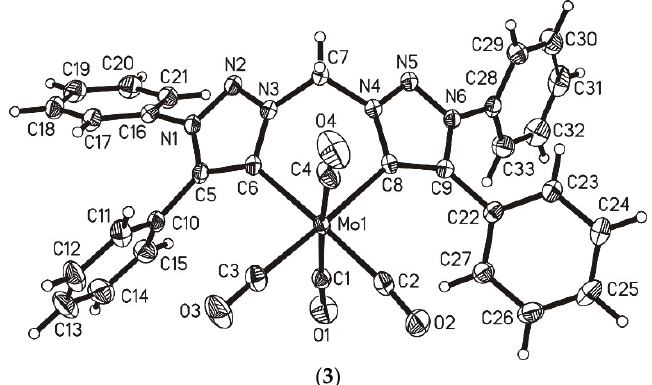
Figure 2. Molecular structure of 1,5-diphenyl-1H-1,2,3-triazole (( 1 ); R = 2.93%, R int = 3.79%), 3,3 ′ -methylenebis(1,5-diphenyl-1H-1,2,3-triazol-3-ium) triflate (( 2 ); R = 4.24%, R int = 8.66%), and [Mo(CO) 4 (bta)] ( 3 ); R = 3.05%, R int = 5.23%). In case of ( 2 ), the two triflate counter ions and in case of ( 3 ), a co-crystallized CH 2 Cl 2 are omitted for clarity reasons. Ellipsoids are shown at the 50% probability level. Table 1. Selected bond lengths (Å) and angles (°) of triazole ( 1 ), bistriazolium salt ( 2 ) and the bis-